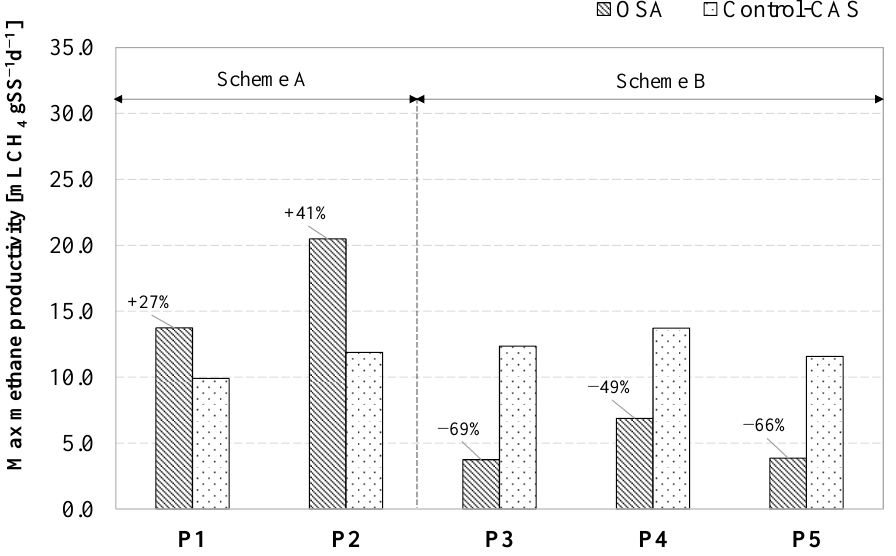
Figure 4. Maximum methane productivity obtained in the BMP assays of the OSA and CAS during the experiment.